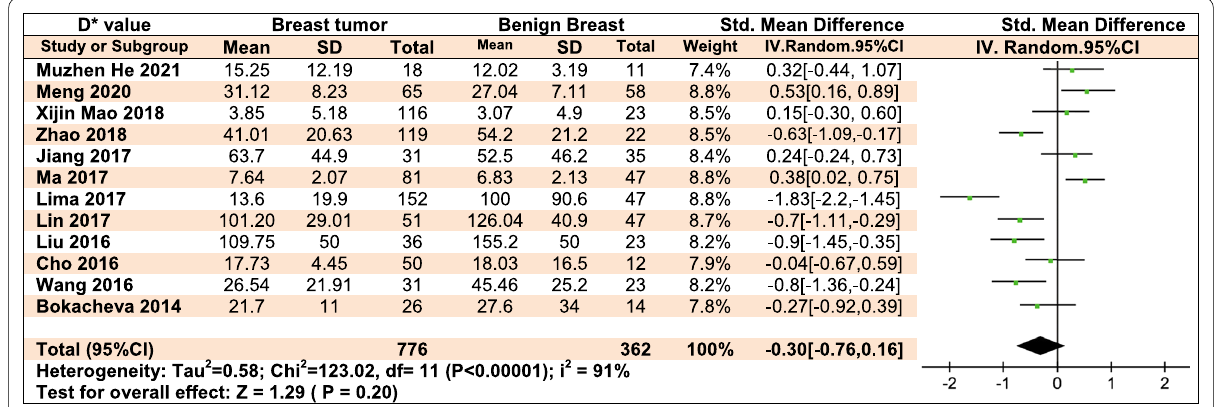
Fig. 4 The mean value of the pseudo-diffusivity ( D *) distinguished among breast lesions